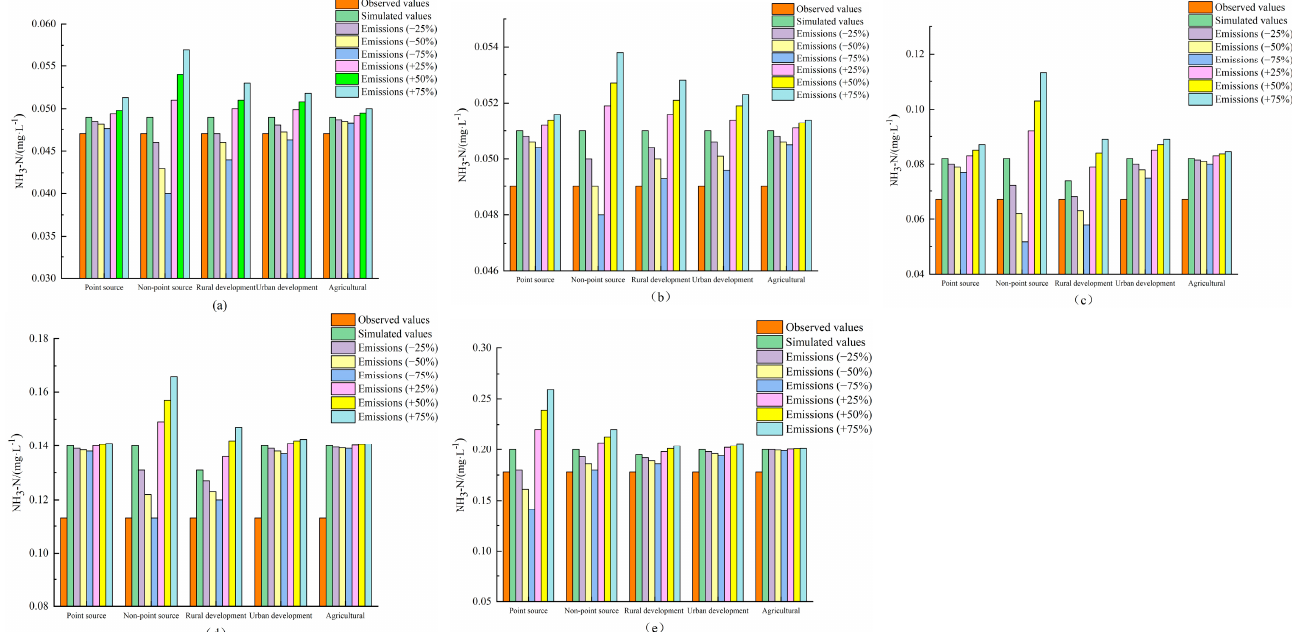
Figure 4. Variations in NH 3 -N concentrations in the Lijiang River cross-section/node at ( a ) Sugar Garden, ( b ) Bedding Face, ( c ) Jiefang Bridge, ( d ) Jingping Bridge, and ( e ) Gangjian Bridge.